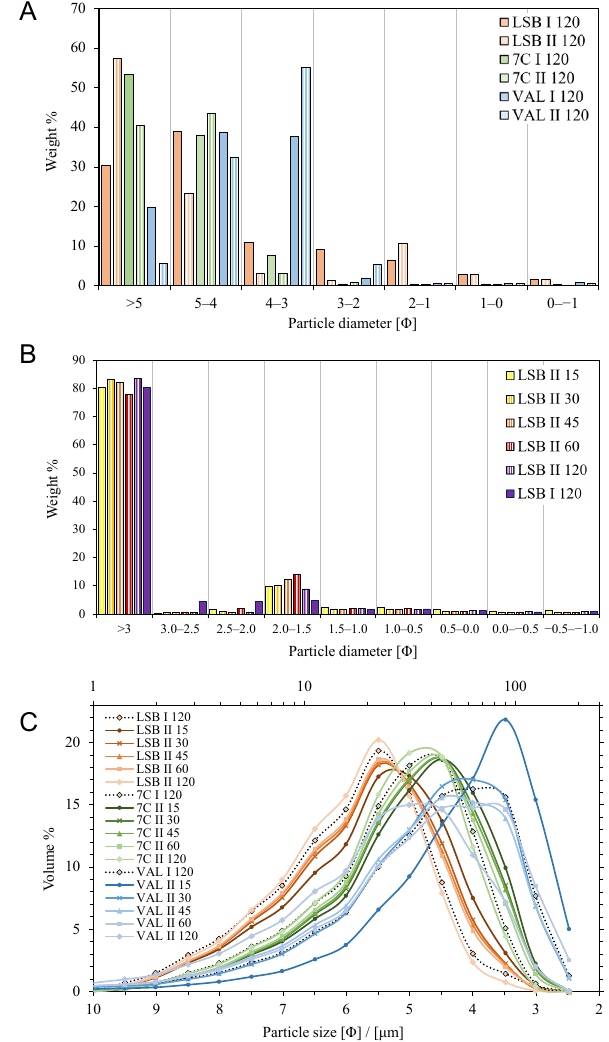
Figure 6: Ash size distributions produced in tumbling experiments. [A] Results from dry sieving between 32 and 2000 µm for all 2 kg starting mass experiments af- ter 120 minutes of tumbling. LSB samples are shown in orange, 7C in green and VAL in blue. In all cases solid and striped bars denote type I and type II experiments, respectively. Note that LSB samples show enrichments in coarse (1–3 Φ ) fractions. [B] Variations in the <3 Φ fractions for LSB 2 kg experiments are highlighted by half- Φ sieving. We note a clear secondary peak at 1.5– 2 Φ for type II experiments, while type I experiments show a coarse tail without a secondary peak extend- ing from 3–1.5 Φ . Colours di ff erentiate experiment time steps, and bar shading follows that in panel [A]. [C] Laser particle size analysis reveals variations in fine ash fractions between samples, experiment types and du- ration. Fine skewing of the distributions occurs with longer tumbling in all cases. Colours denote samples using the same scheme as panel [A]; solid line are used for type II experiments and dotted black lines show a type I 120 minute experiment for each sample. For 7C and LSB type II samples, the mode remains almost con- stant with tumbling duration, while for VAL II samples it decreases from 3.5 to 5 Φ (90 to 40 µm). Note that LSB samples were pre-sieved to <125 µm (>3 Φ ) while VAL and 7C are bulk samples, and that relative variations in the laser particle sizer results are not concordant with sieving data in panel [A]. We attribute these discrepan- cies to small variations in sample humidity leading to fine particle aggregation and defer to the laser particle sizer results for grain sizes <3 Φ